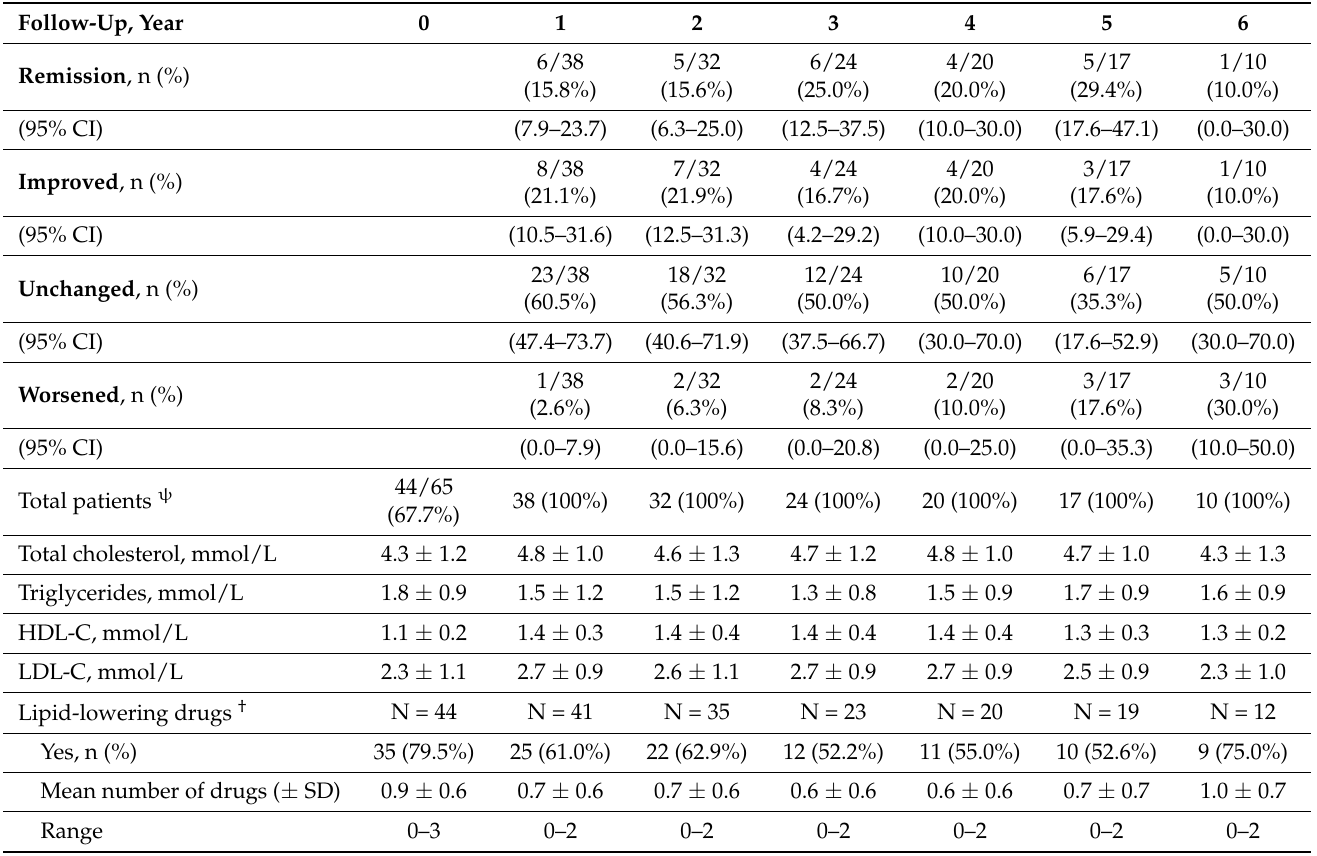
Table 6. Yearly remission, improved, persisting and worsened rates of hyperlipidaemia following bariatric surgery c